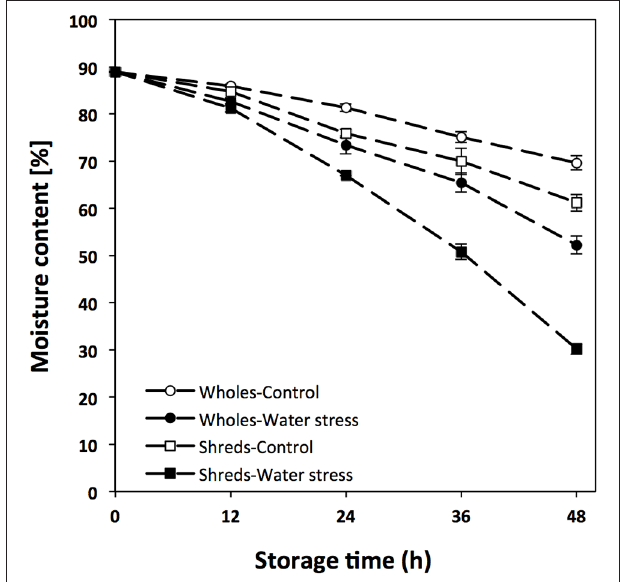
FIGURE 1 | Moisture content [%] of whole and shredded carrots stored for 48h under control and water stress conditions. Values represent the mean of 3 replicates with their standard error